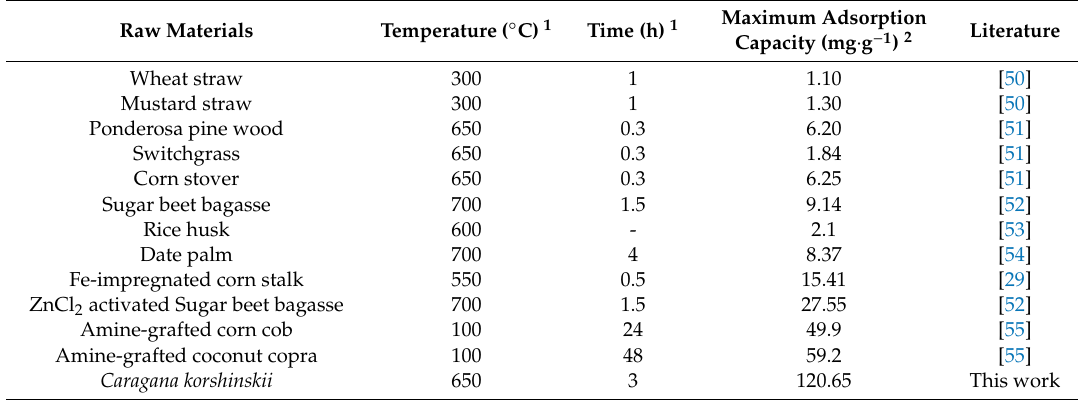
Table 5. Comparison of sorption capacity of CB with selected biochars derived from other materials for NO 3 −